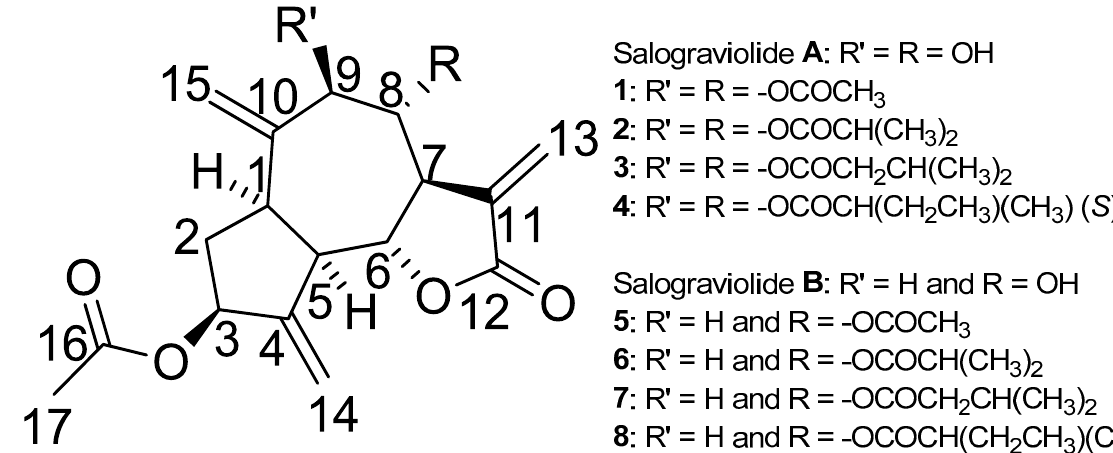
Figure 1. Structures of salograviolide A , B and their ester derivatives ( 1 – 8) .